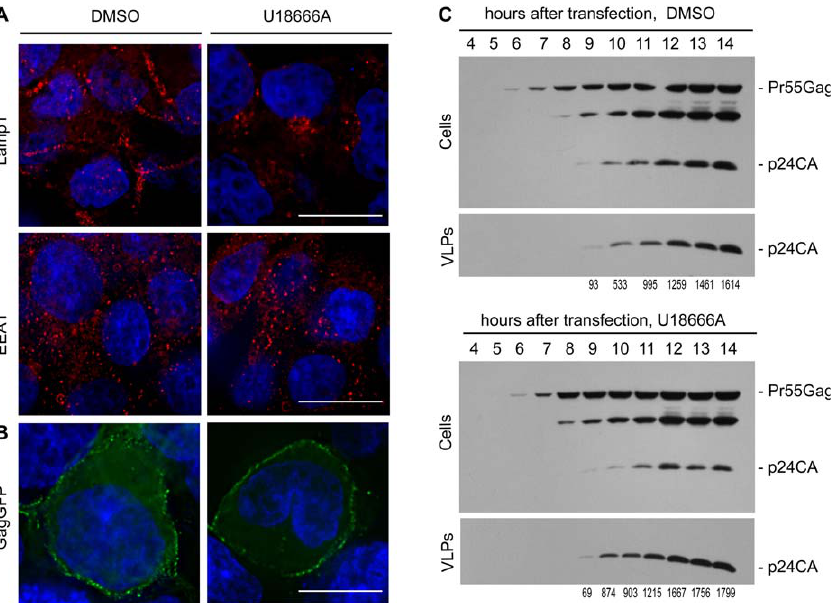
Figure 2. Efficient HIV-1 Particle Formation Does Not Require Late Endosome Motility (A) U18666A induces the collapse of late, but not early, endosomes toward a perinuclear region of 293T cells. Cells treated with U18666A or DMSO for 14 h were fixed and stained with anti-Lamp1 or anti-EEA1 antibodies (red) and Hoechst 33258 (blue). Scale bars indicate 8 l m. (B) 293T cells expressing Gag-GFP (green) in the presence or absence of U18666A, which was added immediately after transfection. Samples were fixed at 14-h post-transfection and stained with Hoechst 33258 (blue). Scale bar indicates 4 l m. (C) Western blot analysis of 293T cells expressing Gag-Pol in the absence or presence of U18666A, which was added immediately after transfection. Samples were collected and analyzed as in Figure 1A. Numerical values below the blots indicate VLP p24CA signal intensities, derived by densitometry; absence of a value indicates undetectable signal. DOI: 10.1371/journal.pbio.0040435.g002